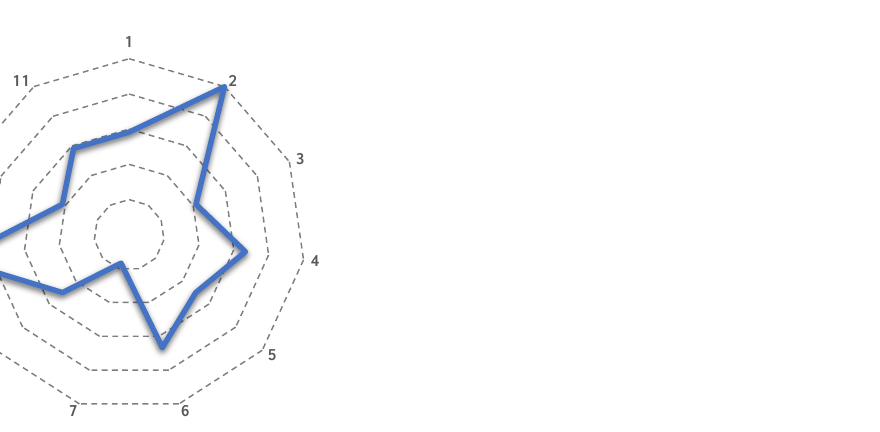
Figure 2. Analysis of security objectives of multimedia content protection techniques achieved by the analyzed systems. Table 1. Comparison of blockchain-based copyright protection schemes with reference to the